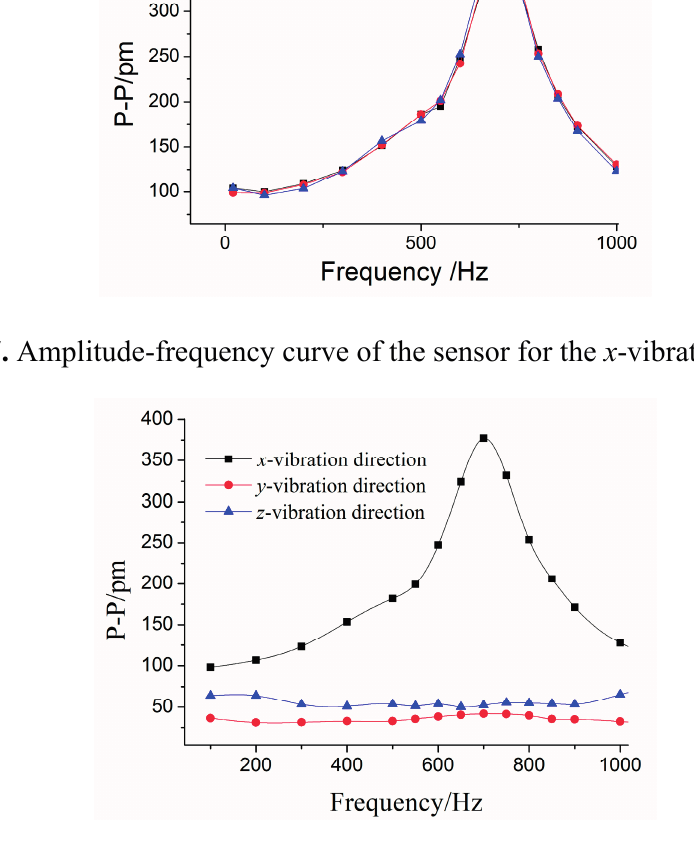
Figure 8. Amplitude-frequency curves of each direction under x -direction